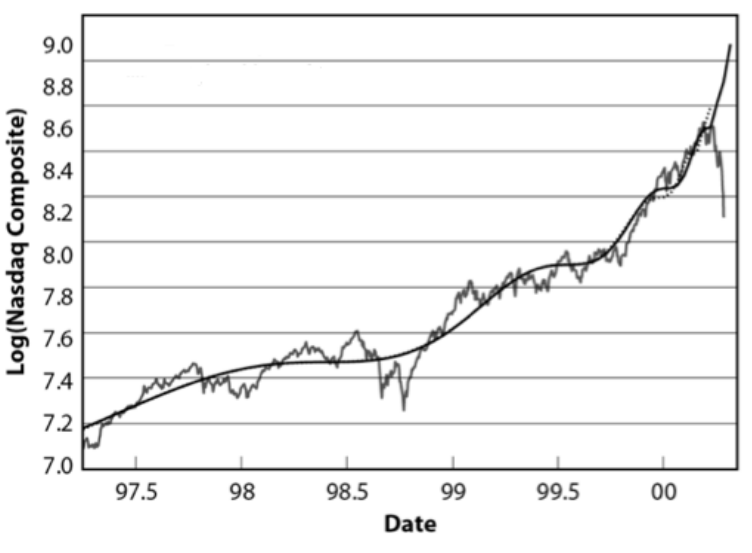
Figure 10. The historical evolution of the Nasdaq composite index showing the price growing faster than an exponential up to its tipping point and the following crash, starting in March 2000. The solid smooth black line shows the result of our model calculations. Reproduced from the book “Why stock markets crash” by D. Sornette [14]. According to our models, the crash occurs shortly before the price reaches its theoretical singularity,